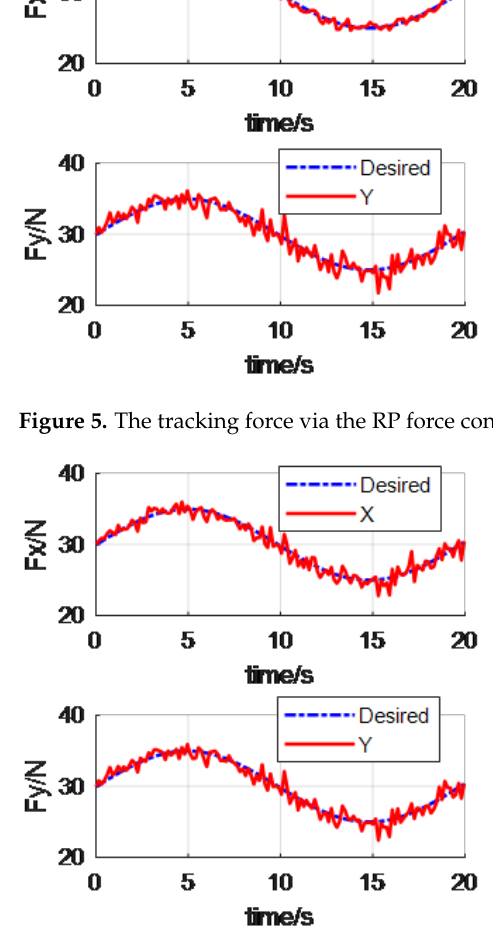
Figure 6. The tracking force via the classical force